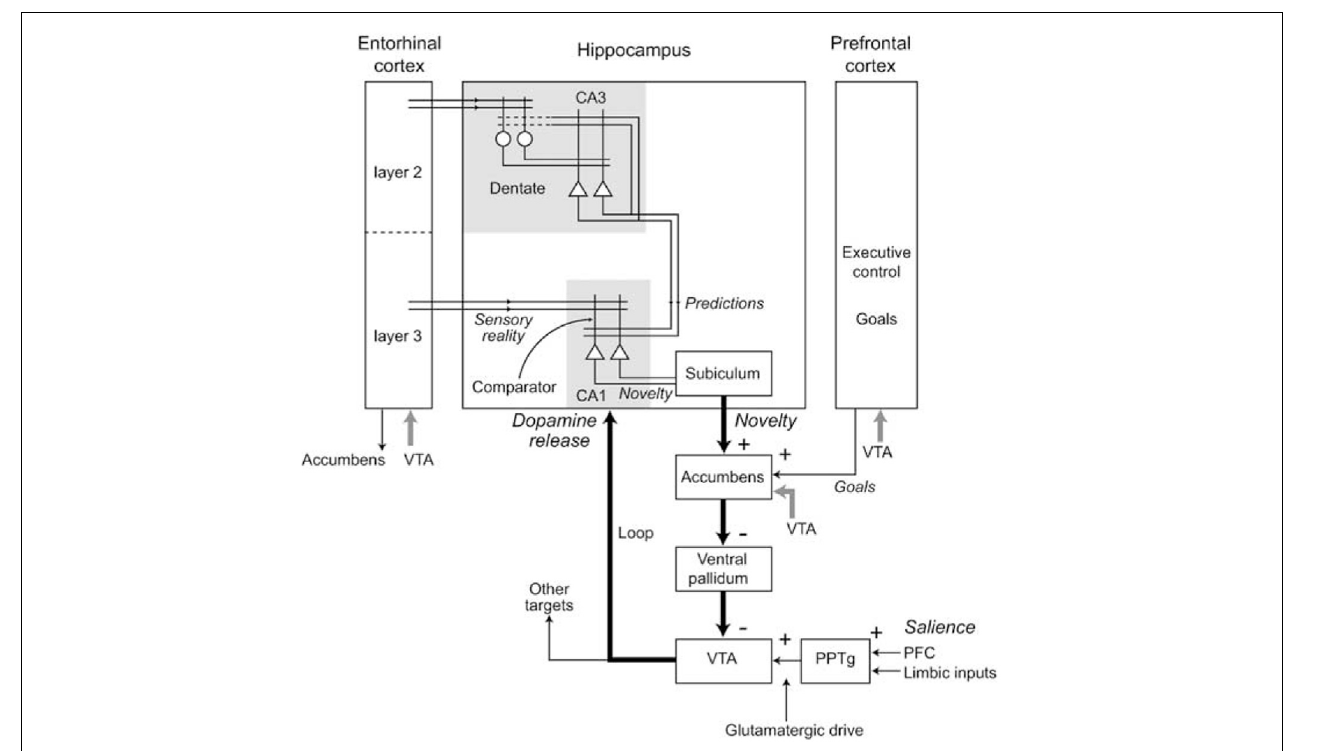
FIGURE 12 | Various components of the Hippocampal system underlying novelty detection in Hip, and the consequent production of dopamine via indirect connections to the VTA. Reprinted from Lisman and Grace (2005), Copyright 2005, with permission from Elsevier.